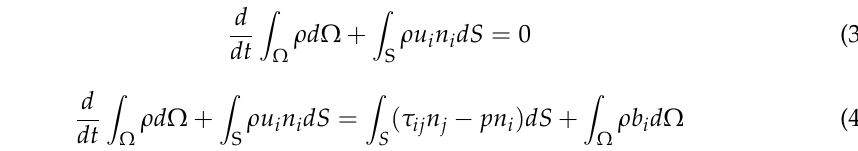
Figure 5. Grid system for numerical simulations. A grid dependency test was conducted to determine the reliability of the numerical analysis. A total of 4 grid sizes were considered, and each grid size is shown in Table 3. The test was operated at an advance coefficient of 0.1 and the convergence of 𝐾 𝑇 and 10𝐾 𝑄 was compared. 𝐾 𝑇 and 10𝐾 𝑄 can be defined as: 𝐾 𝑇 =